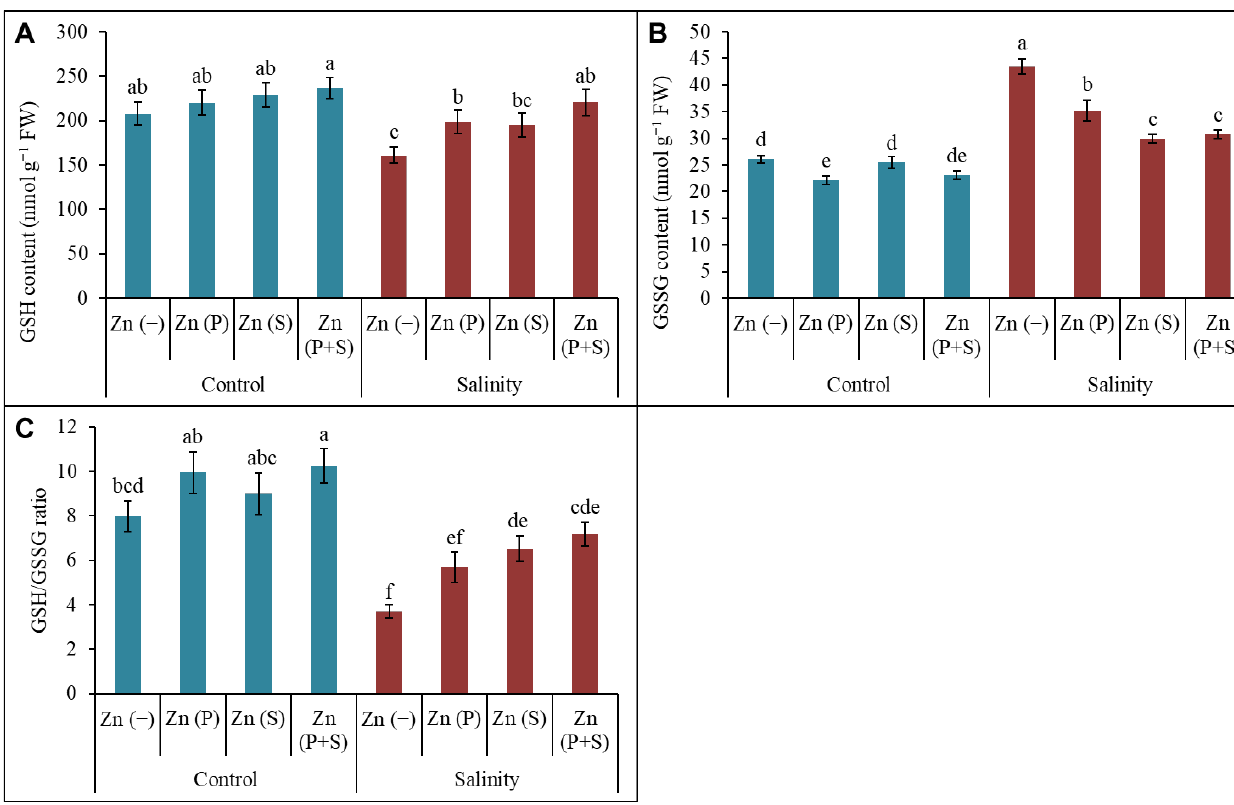
Figure 5. The GSH ( A ) and GSSG ( B ) and GSH/GSSG ( C ) of soybean plants induced by Zn supple- mentation. Twenty five-day-old plants were subjected to salt (150 mM NaCl) and supplemented with Zn (1 mM ZnSO 4 ·7H 2 O). P and S indicate seed priming and foliar application with Zn, respectively. Control treatments were grown with water. Mean (± SD) was calculated from three replicates for each treatment. Different letters of bars indicate significant differences at p ≤ 0.05 applying Tukey’s HSD test.